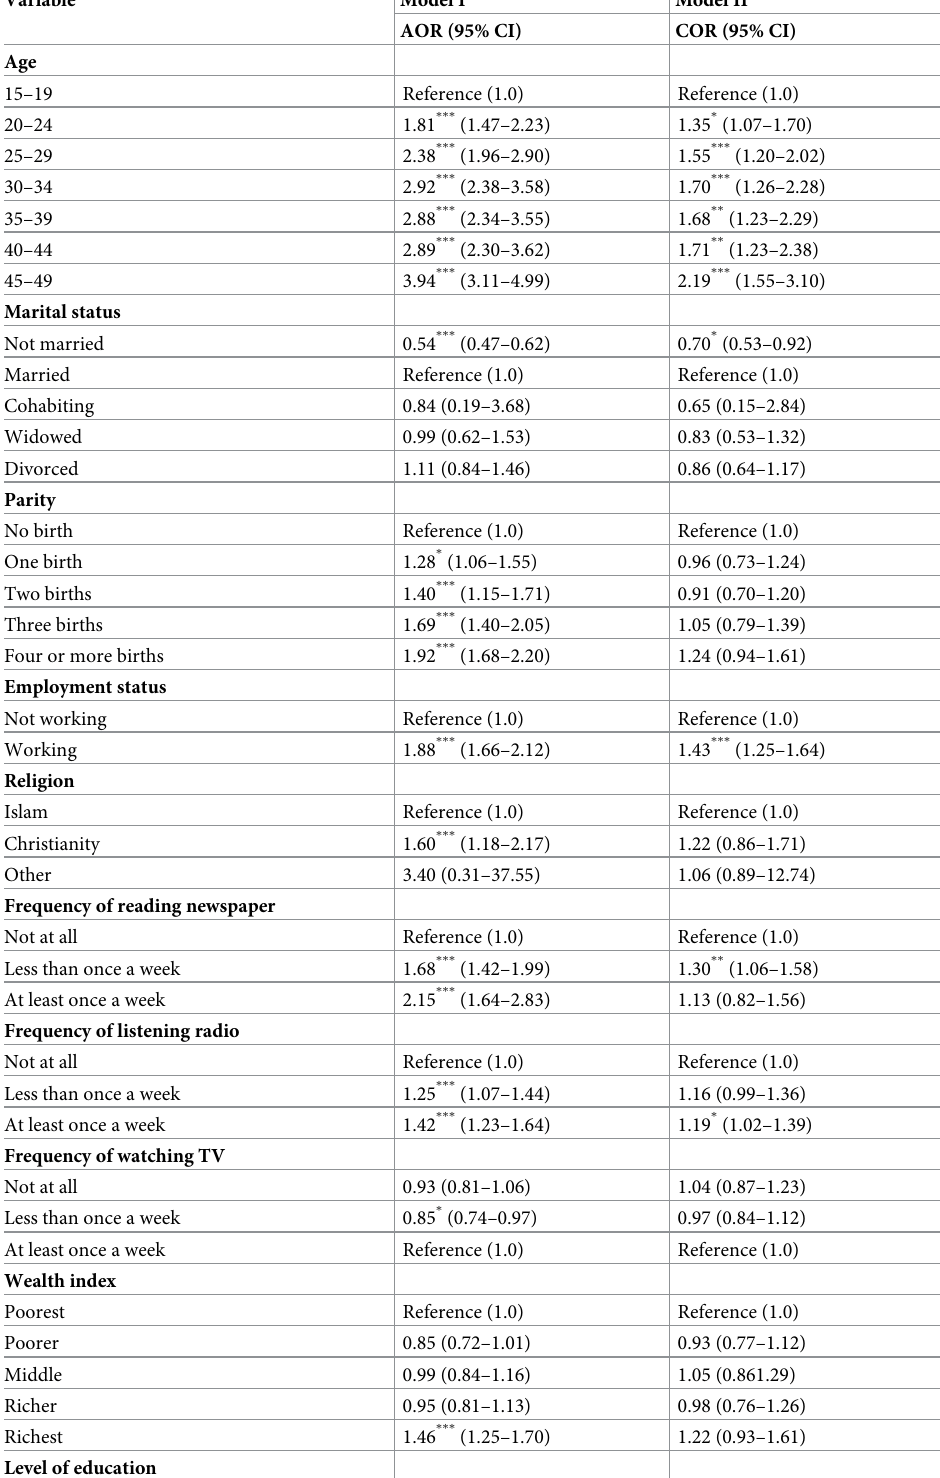
Table 2. Association between explanatory variables and fistula awareness among women in